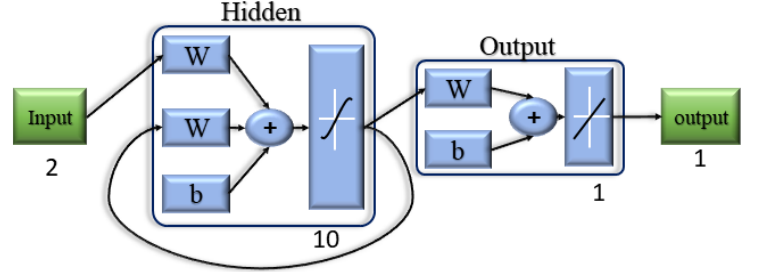
Figure 5. Topology of the recurrent neural